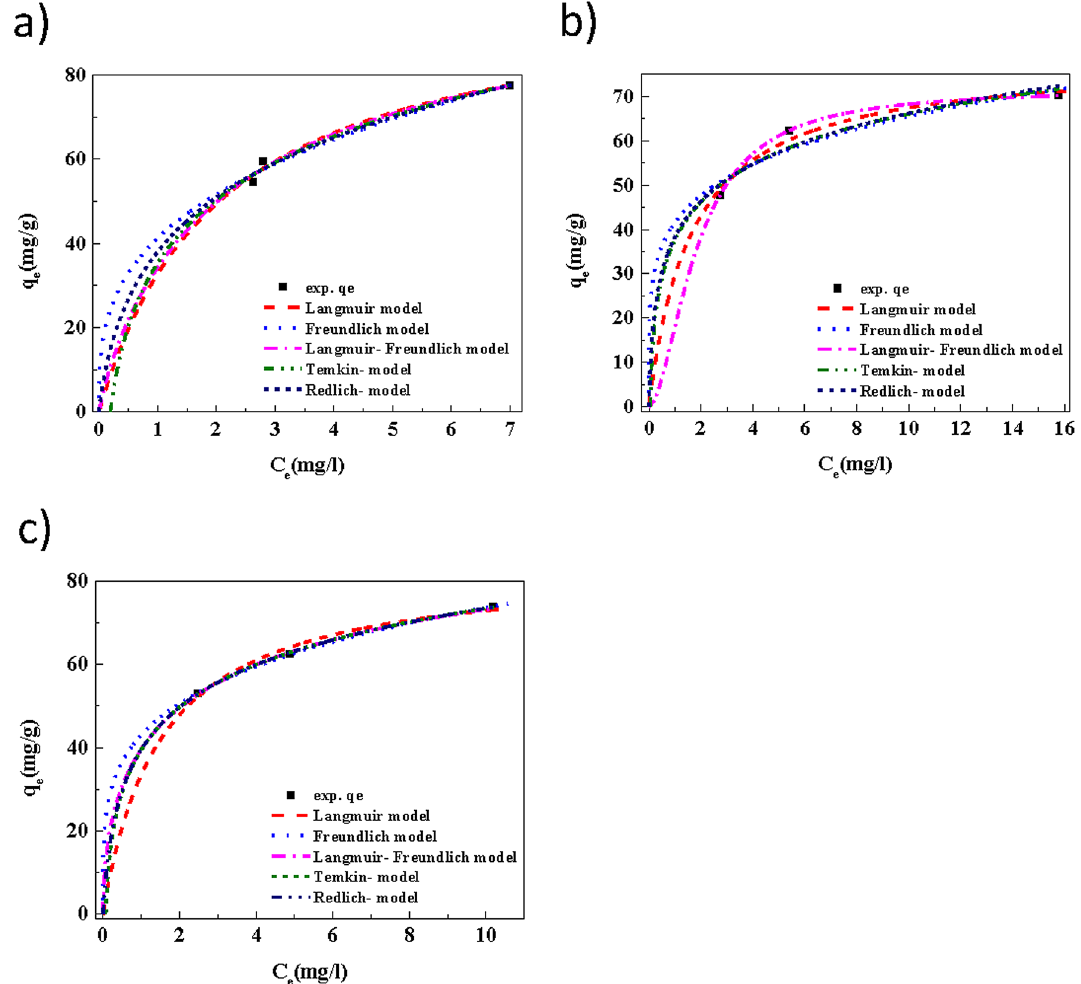
Figure 10. Langmuir, Freundlich, Langmuir–Freundlich, Temkin, and Redlich adsorption isotherms at different temperatures ( a ) 35 °C, ( b ) 45 °C and ( c ) 55 °C) for the adsorption of MB onto Cu(OH) 2 -NWs- PVA-AC Nano-composite. Conditions: MB concentration: 60, 80 and 100 mg/L; Volume = 25 mL, Absorbent dose = 30 mg; Temp. = 35, 45, and 55 °C; Speed of agitation = 200 rpm; Contact time = 60